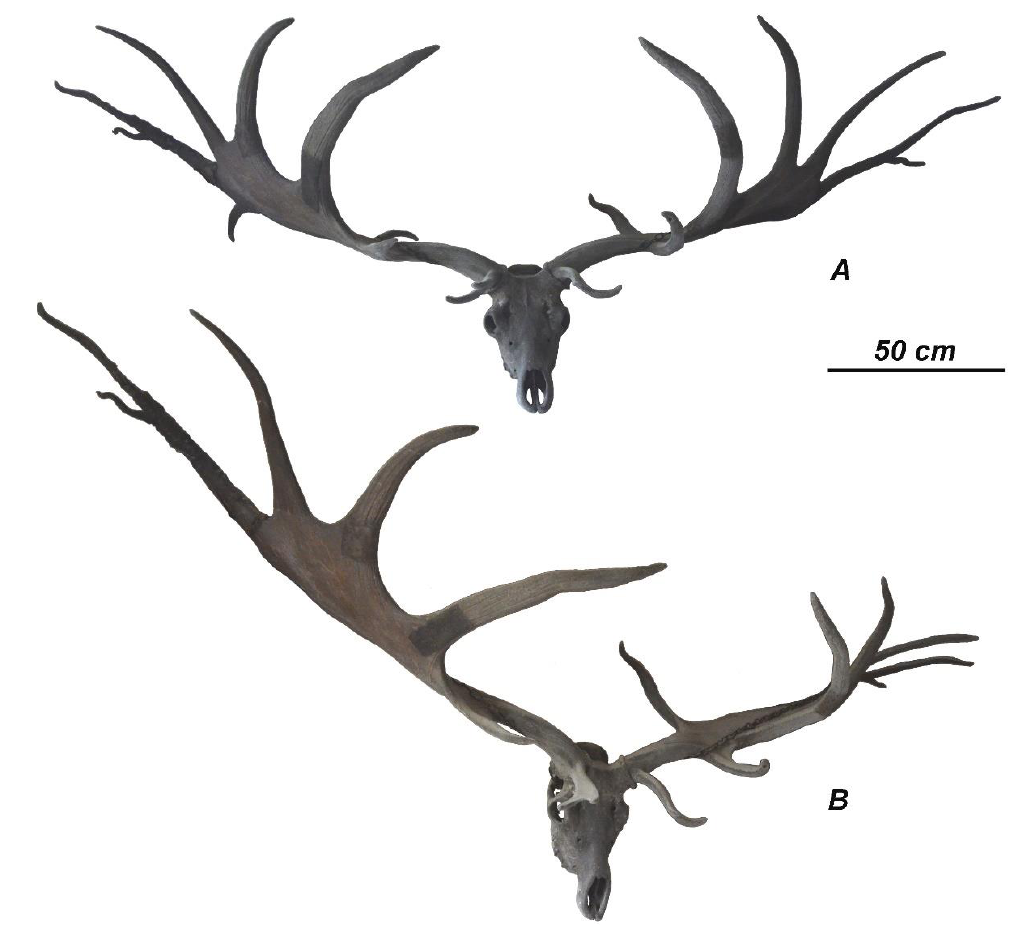
Figure 2. The frontal ( A ) and oblique right ( B ) views of the holotype of Megaloceros giganteus (Blumenbach, 1799) from Dunleer environs (Ireland).